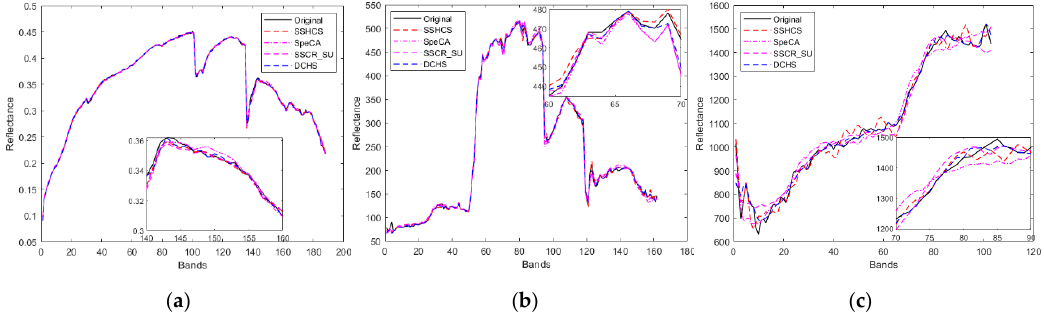
Figure 8. Spectral curves of original and reconstructed achieved by different algorithms. ( a ) Cuprite dataset, ( b )Urban dataset, ( c ) PaviaU dataset.